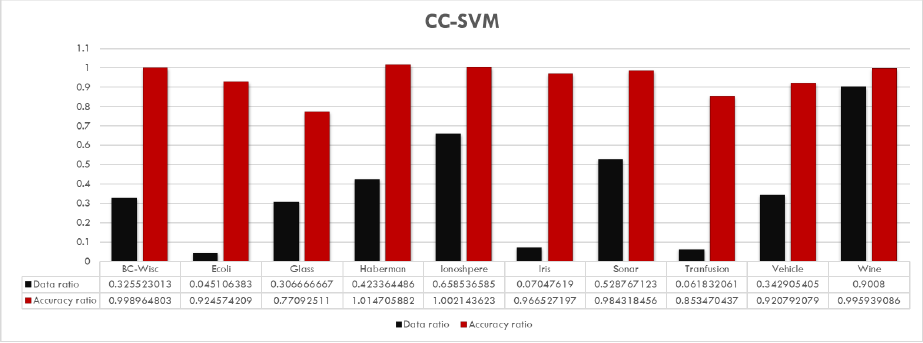
Figure 7. Performance of CC-SVM: data ratio vs. accuracy ratio.